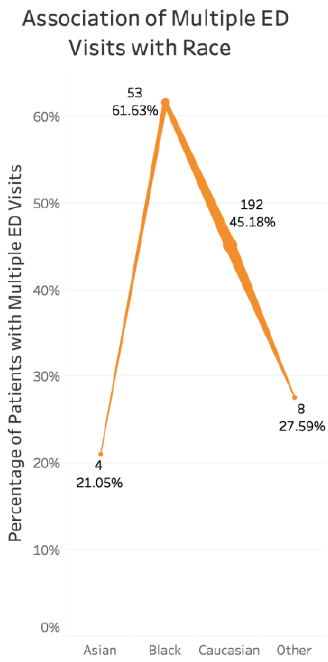
Figure 4. Association of medication use with visits in patients with multiple ED visits. There was a decreased likelihood of multiple ED visits with biologic use ( p = 0.023, coefficient − 0.055) or if pa- tients were previously taking steroids for IBD ( p = 0.0005, coefficient − 0.083).